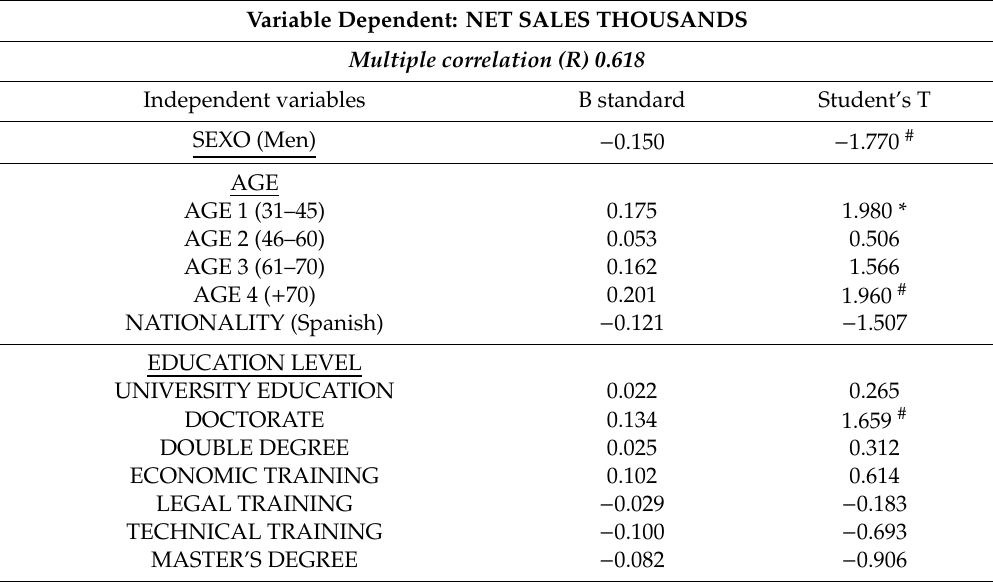
Table 4. Influence variables in IBEX 35 companies NET